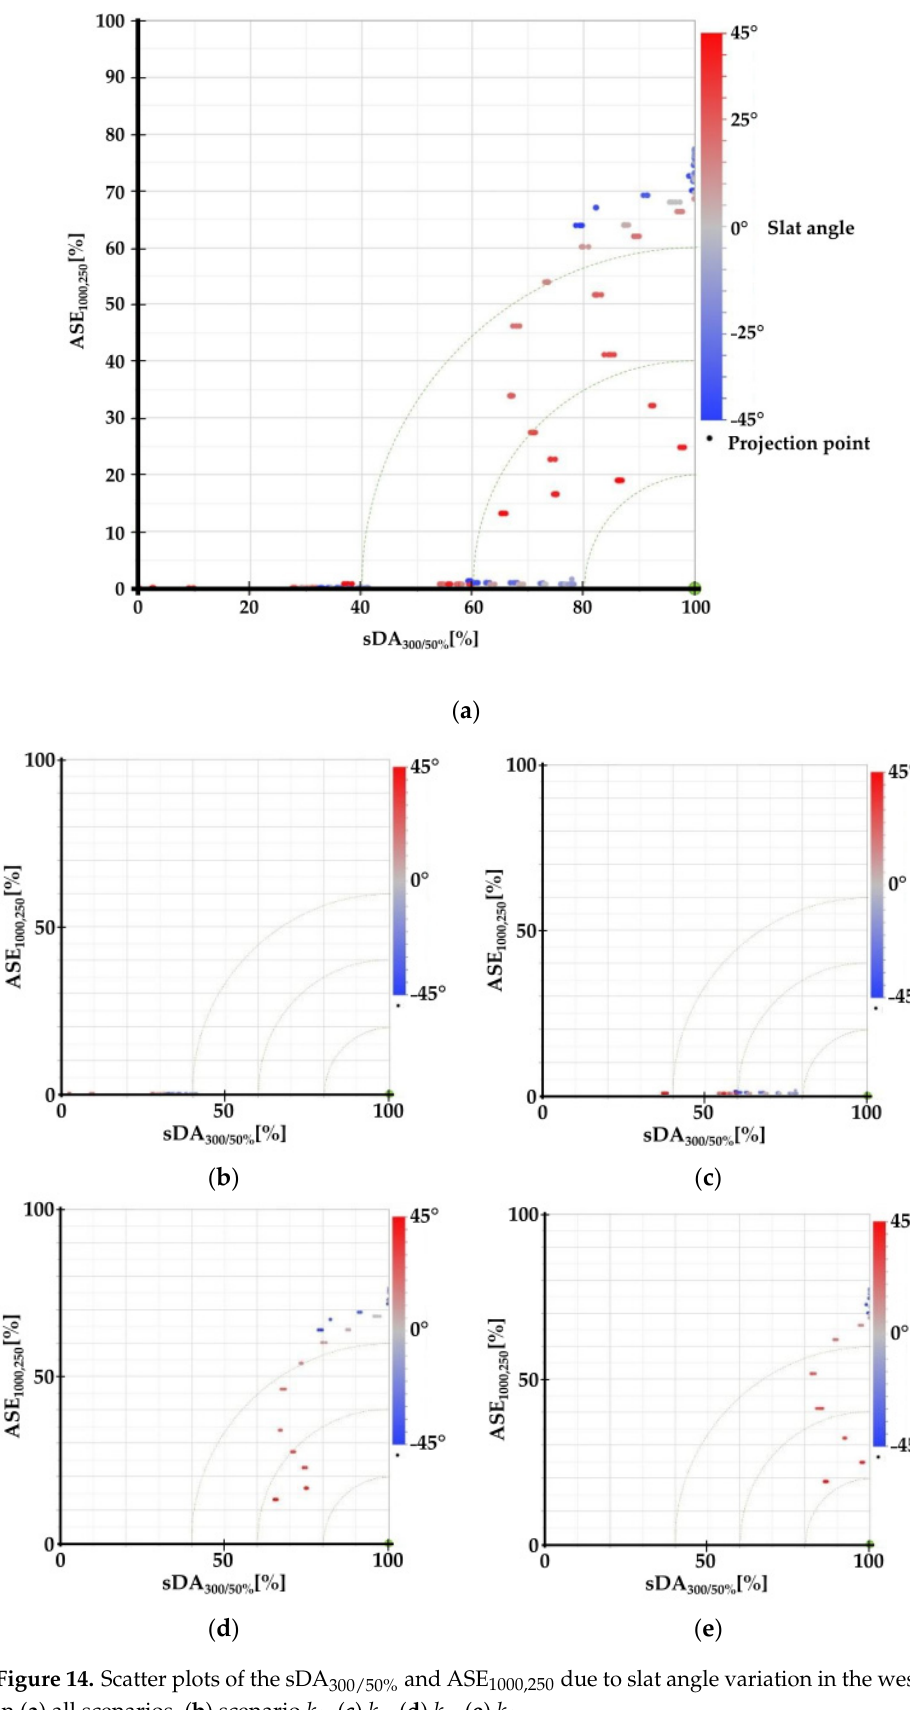
Figure 14. Scatter plots of the sDA 300/50% and ASE 1000,250 due to slat angle variation in the west zone, in ( a ) all scenarios, ( b ) scenario k 1 , ( c ) k 2, ( d ) k 3 , ( e ) k 4 .